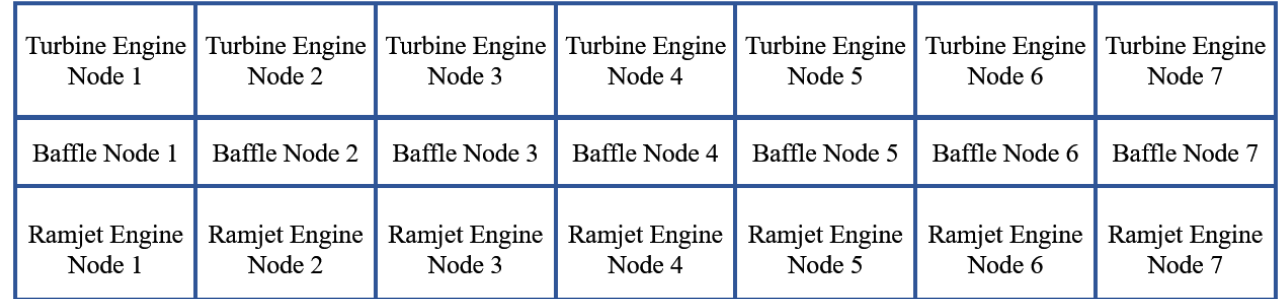
Figure 5. Simulation model of the accessory thermal protection cases. Table 1. Thermal protection method for each component. Component